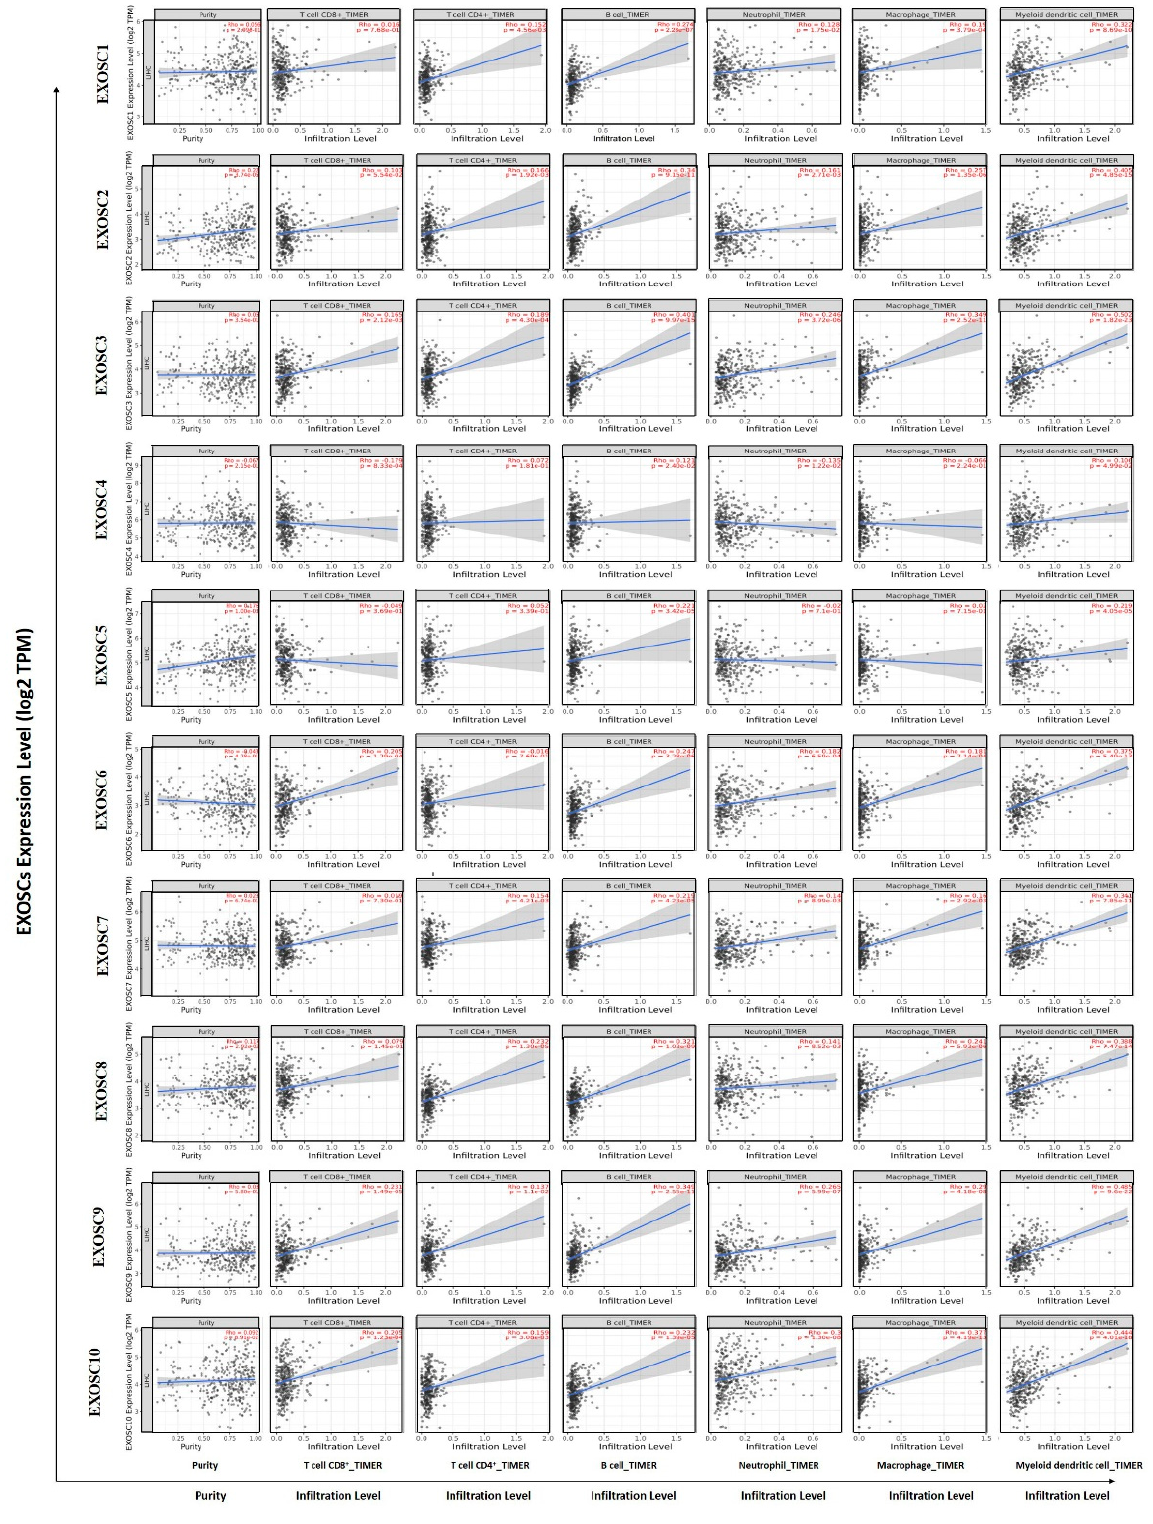
Figure 7. Correlations between differentially expressed EXOSCs and immune cell infiltration. TIMER was used to analyze the correlations between the abundance of immune cells and the expression of EXOSCs family members.